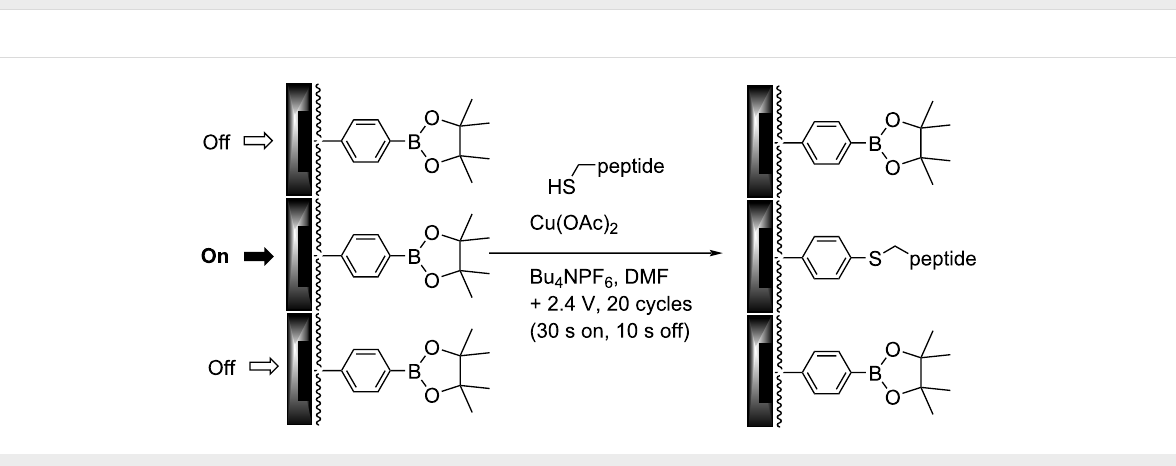
Figure 5: A failure in connection with the monitoring of binding events between a peptide and its G-protein target. a) Binding curve generated for G α i1 binding to scrambled R6A peptide (black), LRSC peptide (red), and R6A peptide (blue). b) Binding curve generated after subtraction of nonspecific binding for G α i1 binding to scrambled R6A peptide (black) and R6A peptide (red).